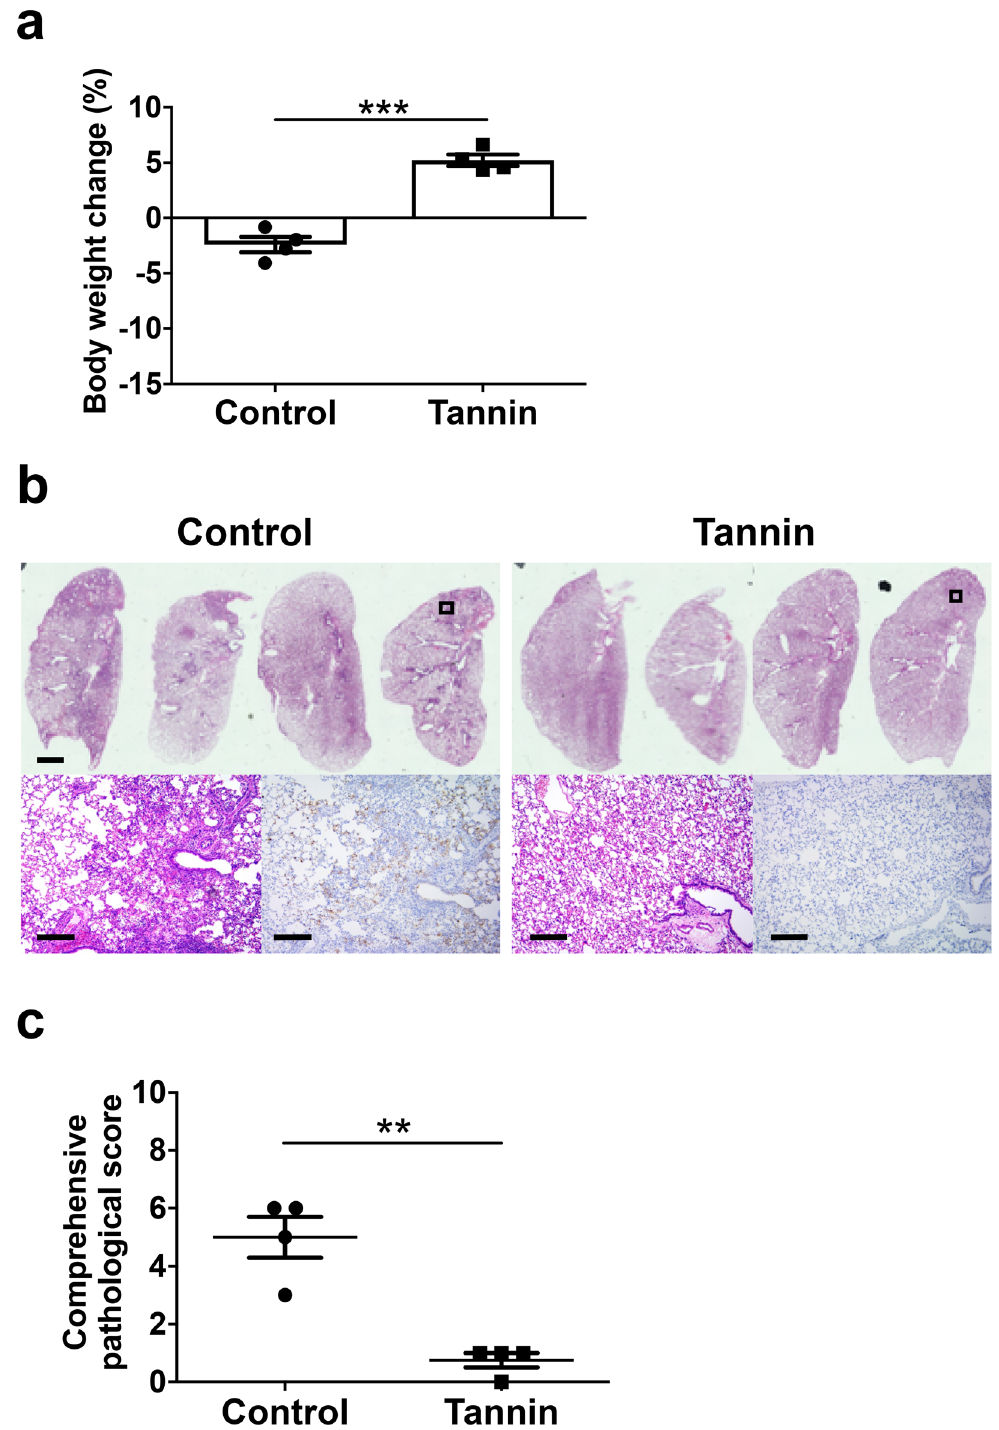
Figure 4. Effect of pre-administration of persimmon-derived tannin on body weight and histopathological changes in contact hamsters cohoused with a virus-inoculated donor. Uninfected hamsters administered with tannin or control solution to their tongue were cohoused with an inoculated donor hamster for 30 min and euthanized 7 days after contact. ( a ) Changes in body weight at 7 days after contact (% weight change compared with the day of contact). ( b ) Pathological findings in the left lungs of the contact hamsters. Views of the left lungs following hematoxylin and eosin (HE) staining are shown in the upper panels. Lower left panels show enlarged views of the area enclosed by the square in the upper panels; lower right panels show immunohistochemistry for SARS-CoV-2 antigen detection in the same area. Scale bars, 2 mm (upper panels) and 200 μm (lower left and lower right panels). ( c ) Comprehensive pathological score of left lung sections derived from HE staining. The scores were calculated based on the severity of pneumonia in the lungs of each hamster. Data are shown as the mean ± SEM (control group, n = 4; tannin group, n = 4). **p < 0.01, ***p <